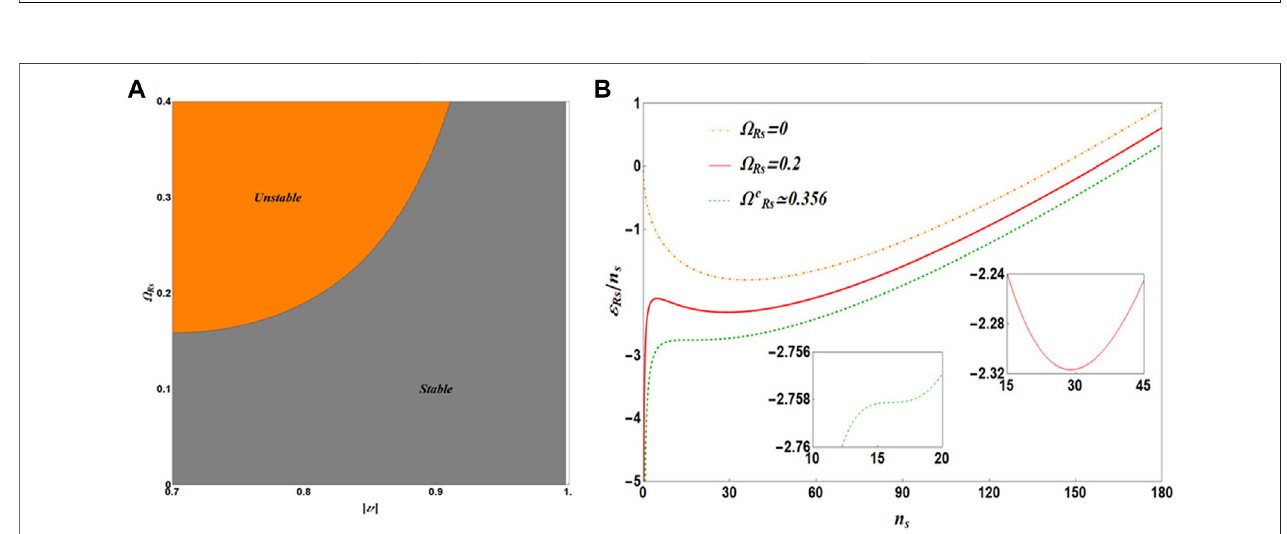
FIGURE 4 | (Color Online) (A) Stability diagram of 1D self-bound Rabi-coupled droplets. The white band shows the asymptotic behavior | υ |~ 1. (B) shows the variation of energy density with density for different Ω Rs . The dot-dashed orange line represents the droplet phase in the absence of Rabi coupling. The solid red line considers Ω Rs = 0.2. The dashed green line corresponds to the critical value Ω c Rs ≃ 0 . 356 at which the system becomes unstable. Inset: we present the local minimum localization of ε Rs / n s predicted by Eq. 13 . This plot is prepared for | υ | =